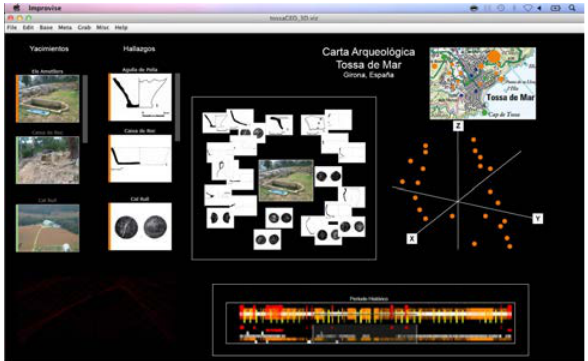
Figure 3. The 3D Collaborative Environment: Archaeological site selection: various resources